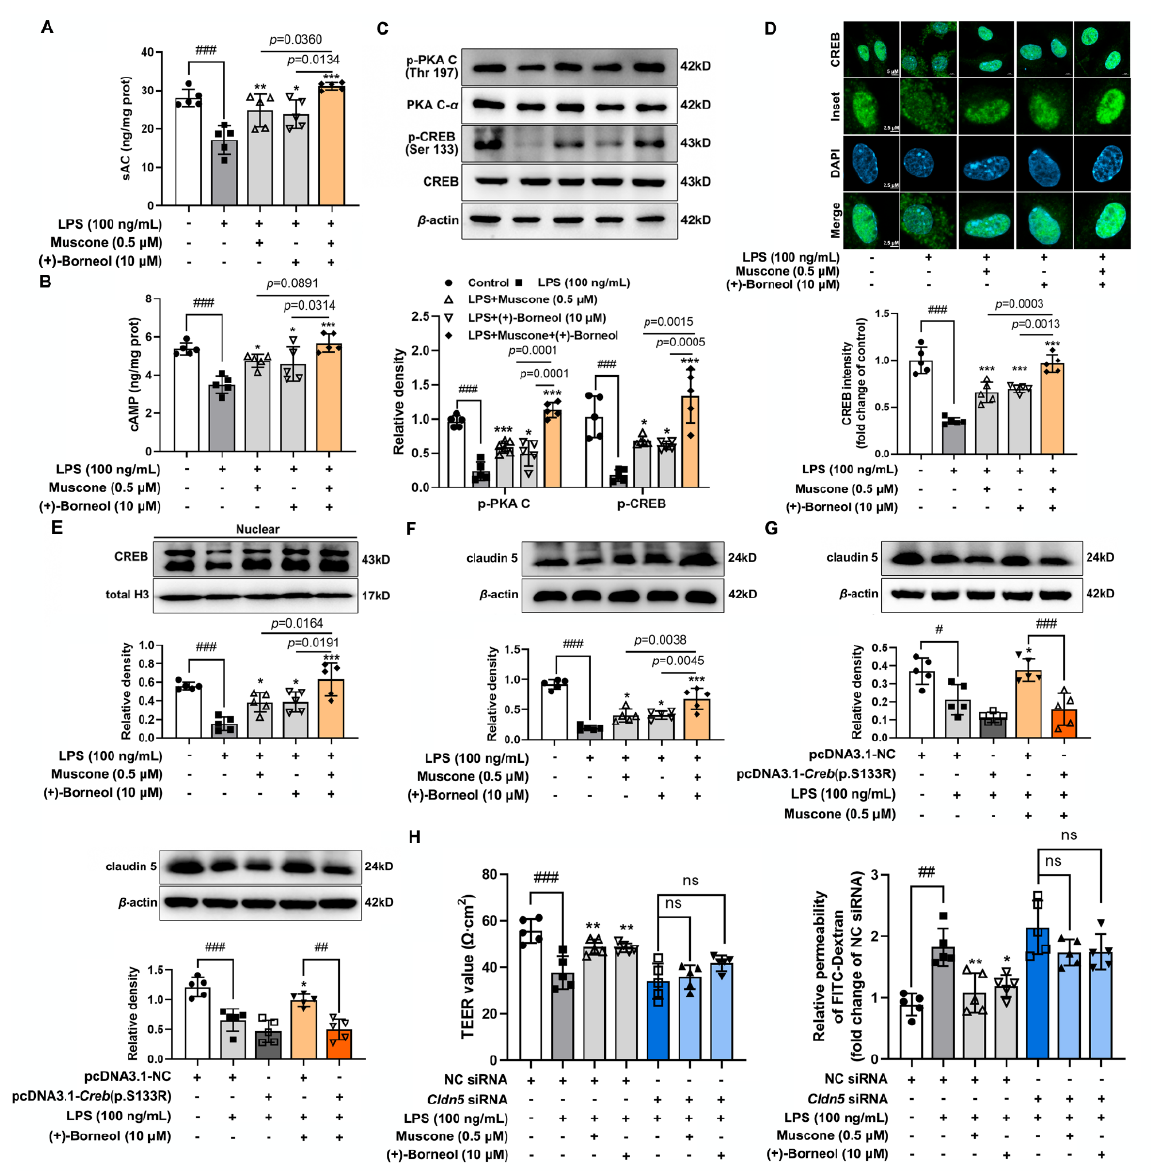
Figure 4. Muscone and (+)-borneol strengthen cAMP/CREB/claudin 5 signaling to maintain cerebral microvascular integrity. ( A ) sAC and ( B ) cAMP contents in the lysis of bEnd.3 cells were detected ( n = 5); ( C ) protein levels of p-PKA C, PKA c- α , p-CREB (Ser 133), and CREB were measured in LPS-stimulated bEnd.3 cells; ( D ) the nuclear translocation of CREB in bEnd.3 cells were labeled by immunofluorescent staining ( n = 5, scale bar: 5 µ m or 2.5 µ m); ( E ) protein expression of CREB in the nucleus of LPS-stimulated bEnd.3 cells ( n = 5); ( F ) protein expression of claudin 5 in bEnd.3 cells treated with muscone and (+)-borneol in the presence of LPS for 16 h; ( G ) protein expression of claudin 5 in bEnd.3 cells when transfected with CREB mutation at Ser133 site and then treated with muscone or (+)-borneol in the presence of LPS ( n = 5); ( H ) bEnd.3 cells cultured in a 0.4 µ m Transwell membrane were transfected with Cldn5 siRNA. Then, the TEER values and FITC-dextran permeability were measured in the presence of LPS ( n = 5). Data are presented as mean ± SD ( n = 5). * p < 0.05, ** p < 0.01, *** p < 0.001 vs. LPS treatment; # p < 0.05, ## p < 0.01, ### p < 0.001 vs. indicated treatment; ns: no significant different. p values are determined by one-way ANOVA followed by Tukey’s